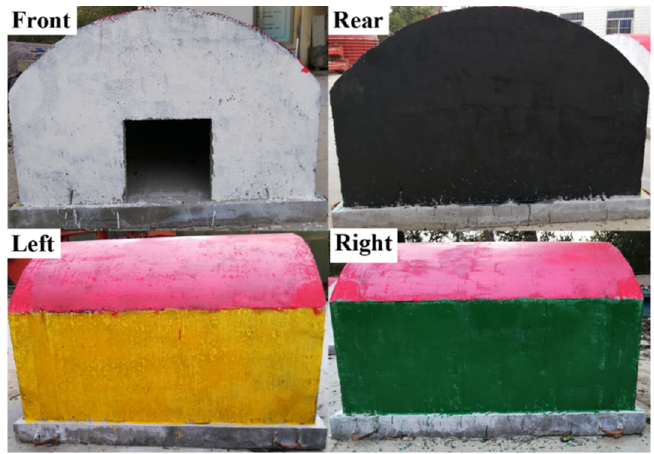
Figure 5. Surface treatment of model.